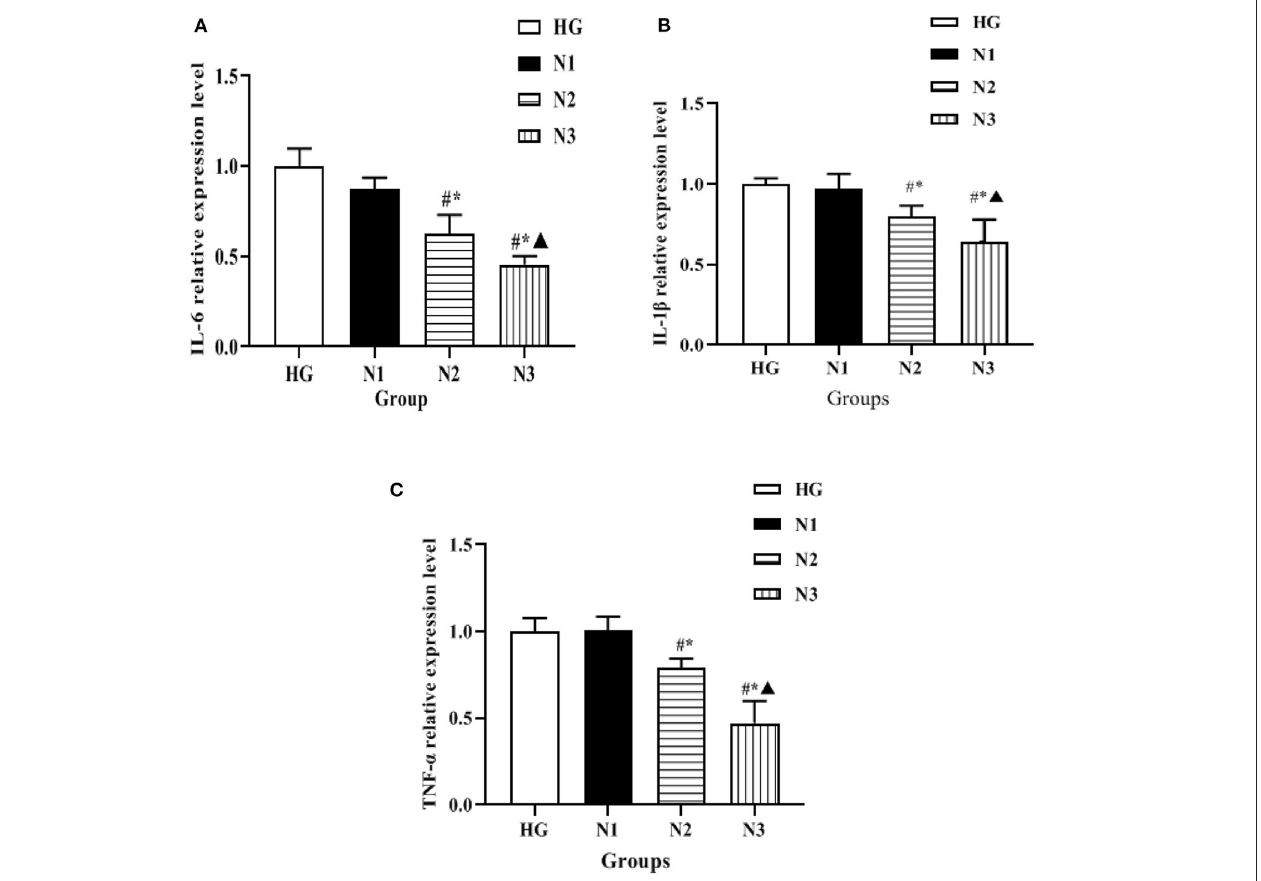
FIGURE 3 | Expression levels of inflammatory factors in H9c2 cells in each group. In the above figure, (A) the comparison of IL-6 expression levels in the four groups of H9c2 cells, (B) the comparison of IL-1 β expression levels in the four groups of H9c2 cells, and (C) the comparison of TNF- α expression levels in the four groups of H9c2 cells. Compared with HG group, # P < 0.05; compared with N1 group, * P < 0.05; compared with N2 group, N P < 0.05. TG levels of rats in S2 and S3 groups were significantly lower than those in DCM group ( P < 0.05), as shown in Figure 4